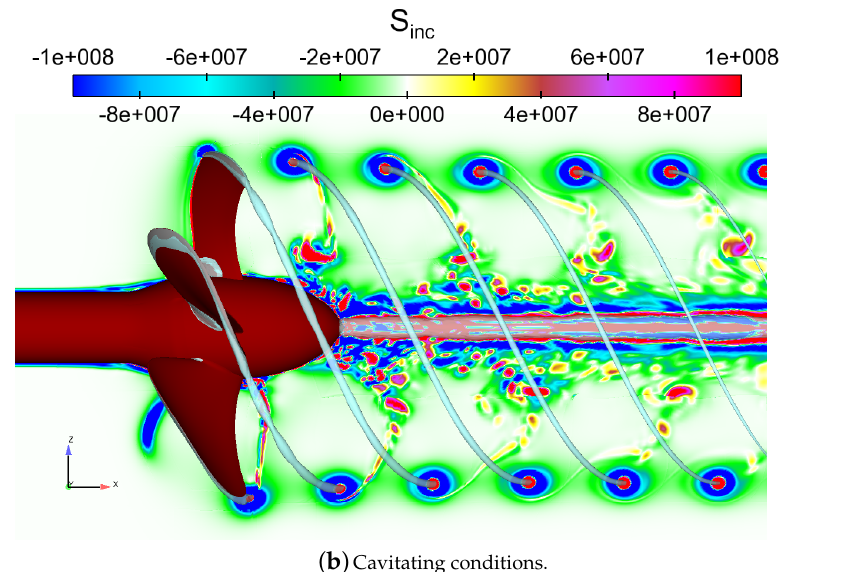
Figure 18. Distribution of the acoustic source term based on delayed detached eddy simulation (DDES) near the propeller on the cut plane y = 0. In the cavitating case, the iso-surface of the void fraction α = 0.1 is coloured by light